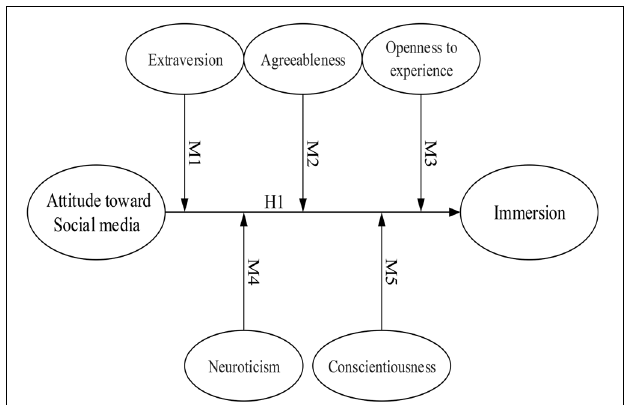
FIGURE 1 | Research